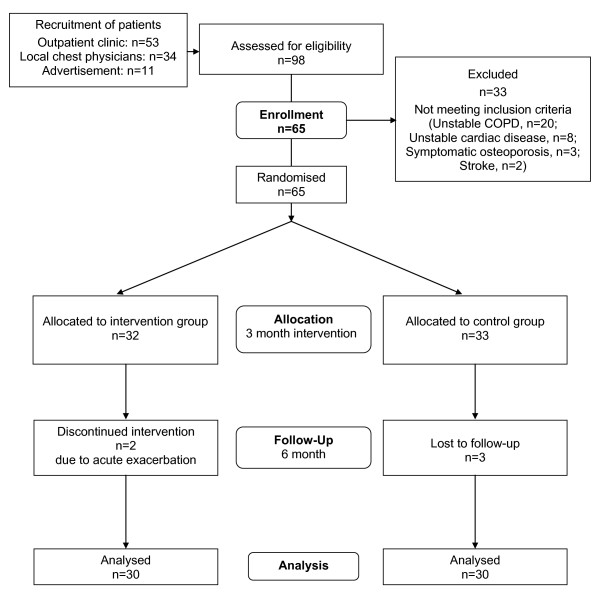
Patient flow diagram.